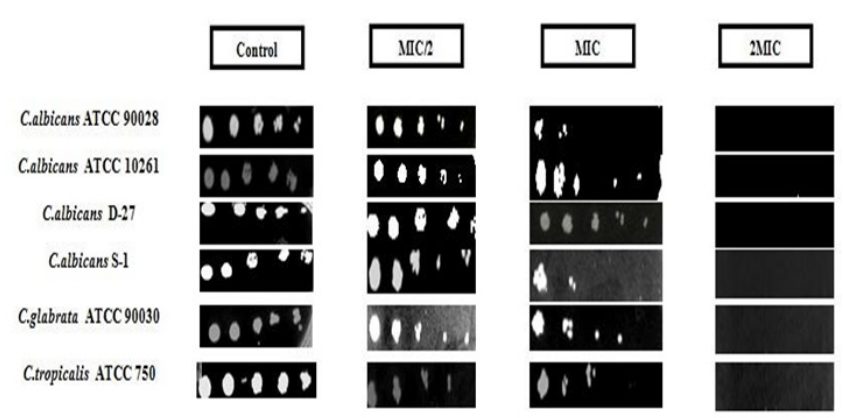
Fig. 2. Spot assay showing susceptibility of C. albicans (ATCC 90028, ATCC 10261, sensitive strain (D-27), resistant strain (S-1), C. glabrata and C. tropicalis to varying concentrations of geraniol. Control has no test